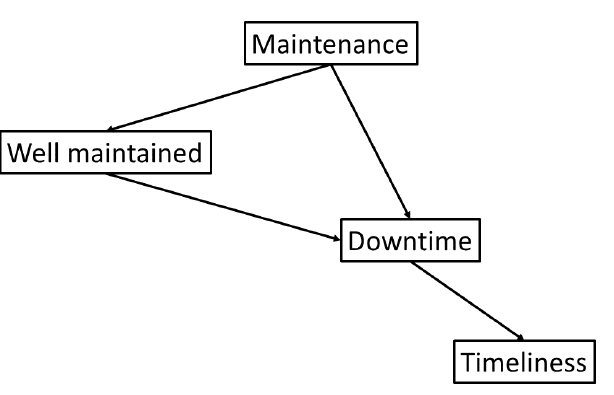
Figure 2. Partial cognitive map of example semiconductor problem